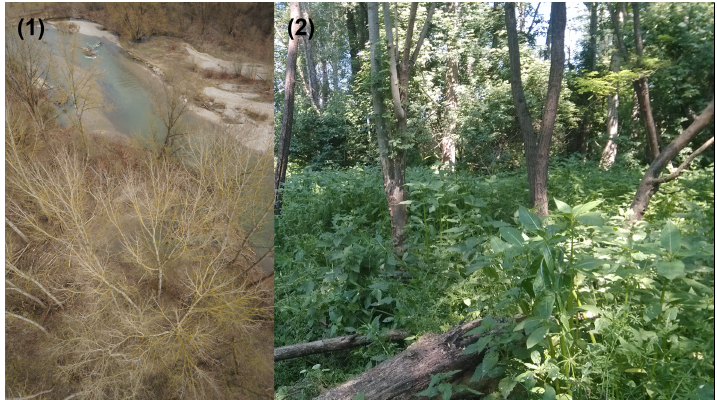
Figure 2. ( Left ) Image from the UAV mounted camera showing the alluvial forest and the river Pielach in the background from February 2015. Location and viewing direction as seen in Figure 4; ( Right ) Image within the forest during the terrestrial field measurement campaign in June